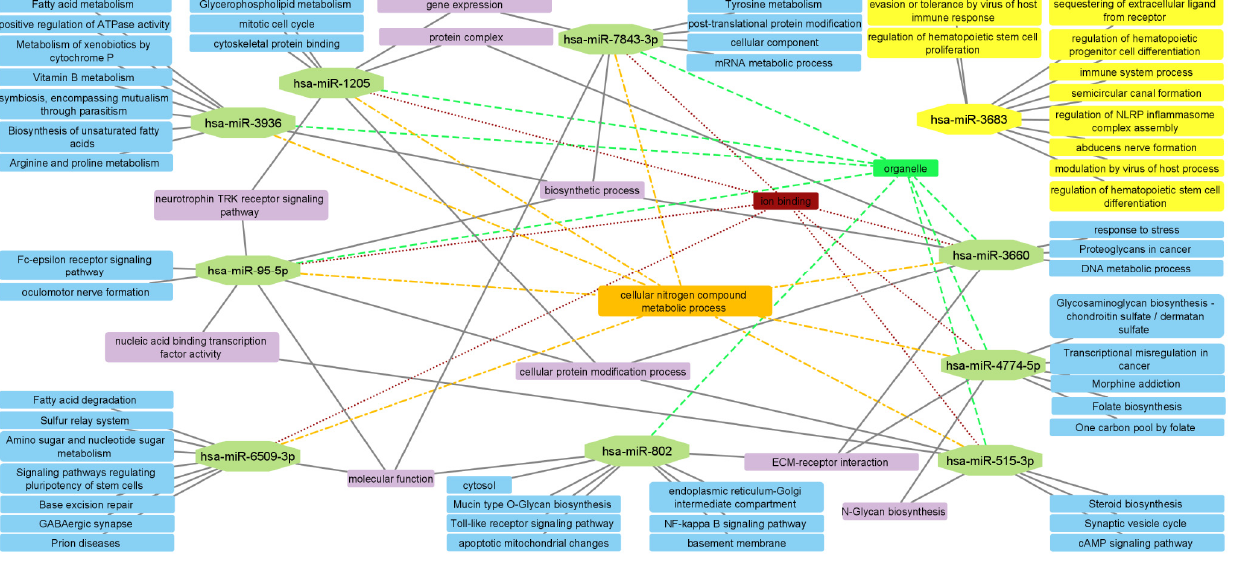
Figure 4. Functional network performed using selected upregulated miRNAs in PEXG. The network is made up of the 10 most statistically significant for each miRNA. Analysis made using DIANA-miRPath v3.0. The functional network for downregulated miRNA functionally linked together nine miRNAs (leaving one type of miRNA without functional linkage—hsa-miR-3683). The terms with the most associations between the selected miRNAs were: “Ion binding”, “organelle”, “biosynthetic process”, “cellular nitrogen compound metabolic process”, “molecular function” and “molecular function”.